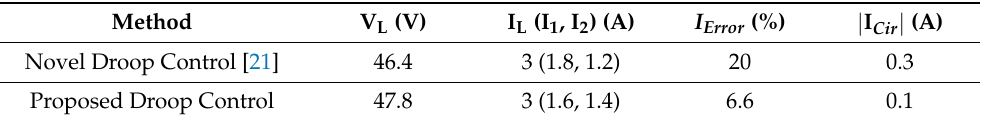
Table 11. Comparison of experimental results of different methods considering variation in source voltage and load with different cable resistances.